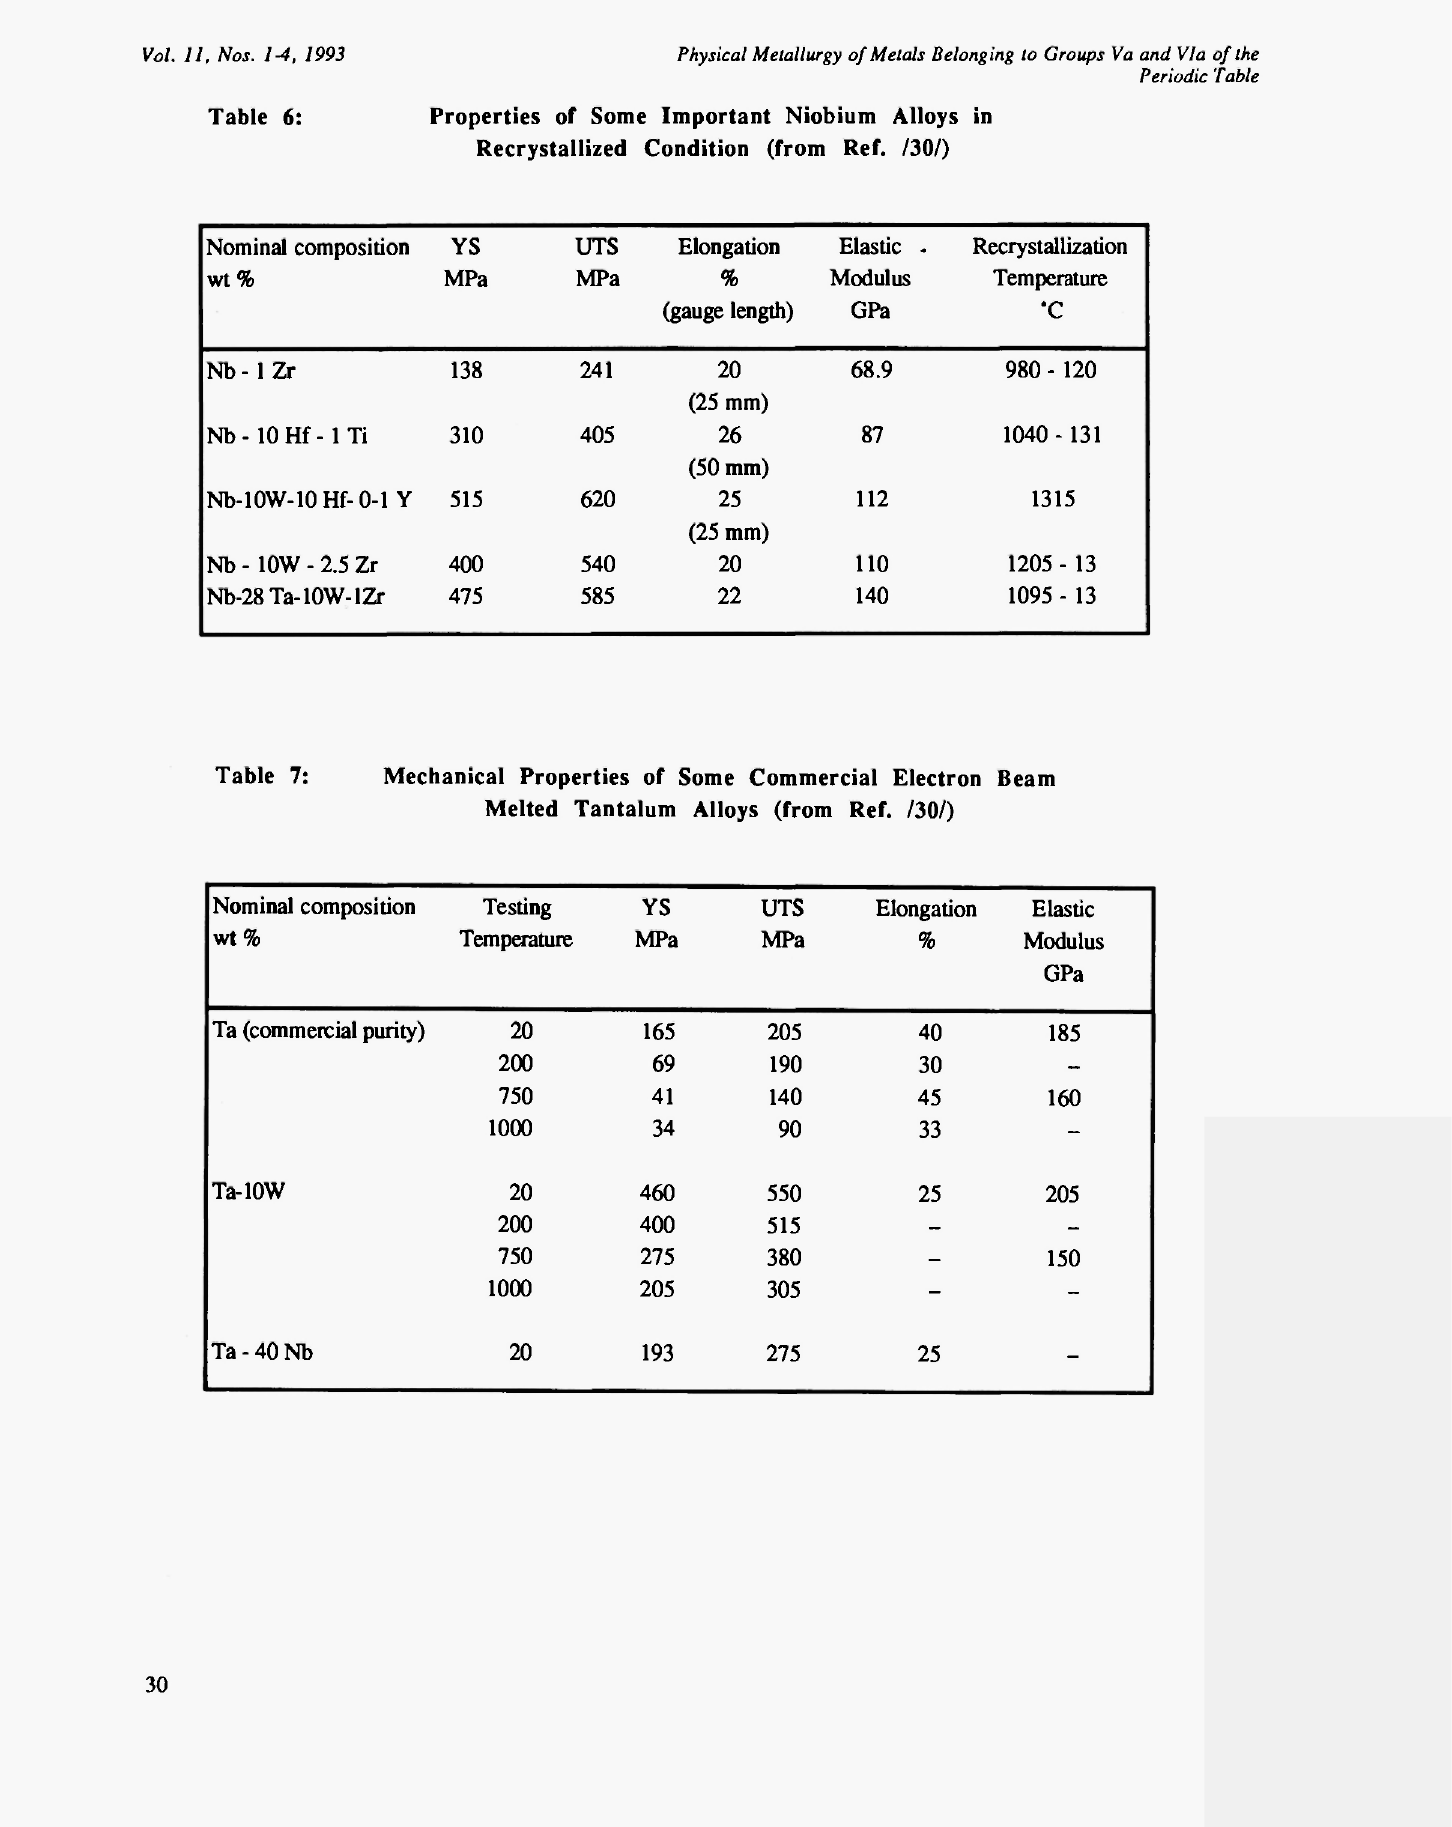
Physical Metallurgy of Metals Belonging to Groups Va and Via of the Periodic Table Table 6: Properties of Some Important Niobium Alloys in Recrystallized Condition (from Ref. /30/)